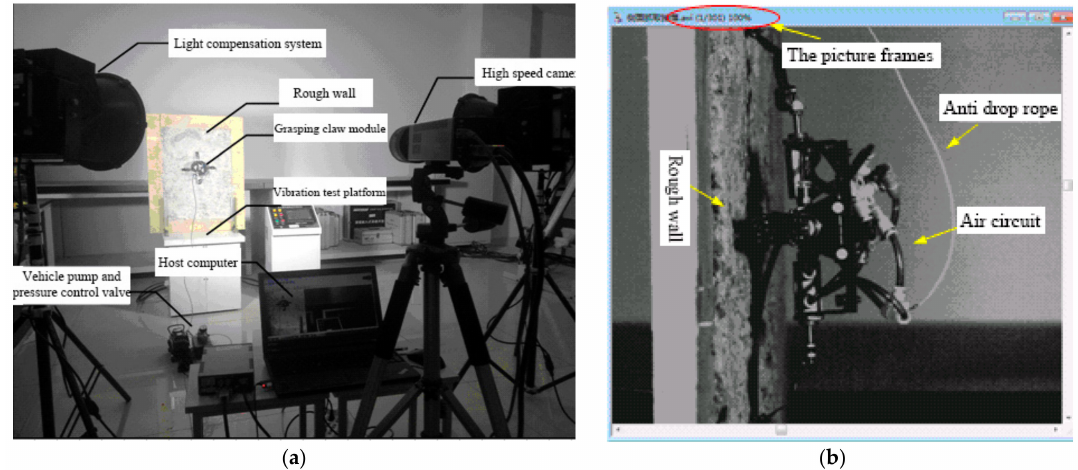
Figure 14. Indoor grabbing experiments of the grasping claws. ( a ) Vibration experiment of the grasping claws; ( b ) The picture of grabbing process.